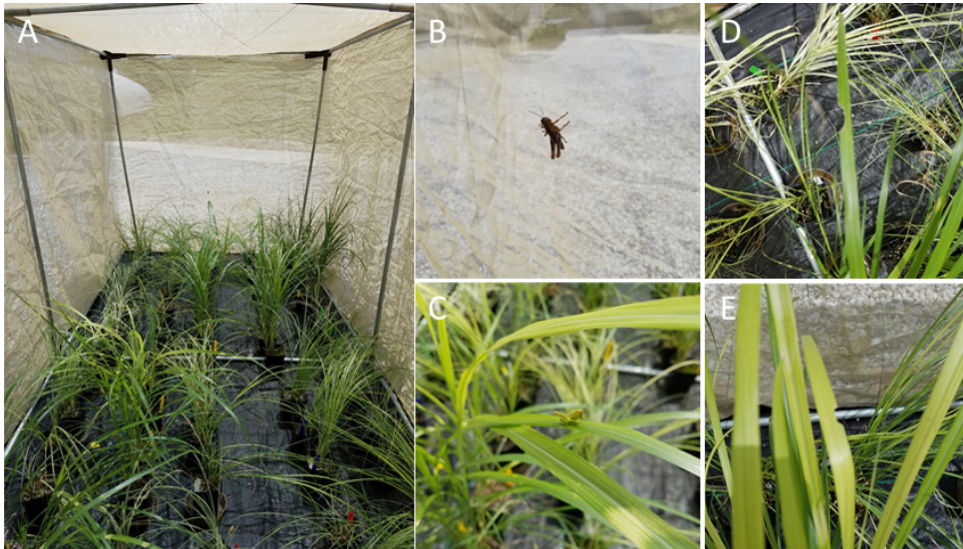
Figure 7. Miscanthus sinensis cultivars during the cage experiment at the Research Plant Growth Facility of the University of Maryland (College Park, MD, USA). ( A ) The plants inside the enclosure, 1st day pf the grasshopper herbivory assay; ( B ) A nymph of Melanoplus spp. grasshopper on a side wall of the enclosure; ( C ) A nymph of Melanoplus spp. grasshopper on “Zebrinus” cultivar inside the enclosure; ( D , E ) grazed portion left by grasshopper along the mid-veins of M. sinensis cul- tivars.